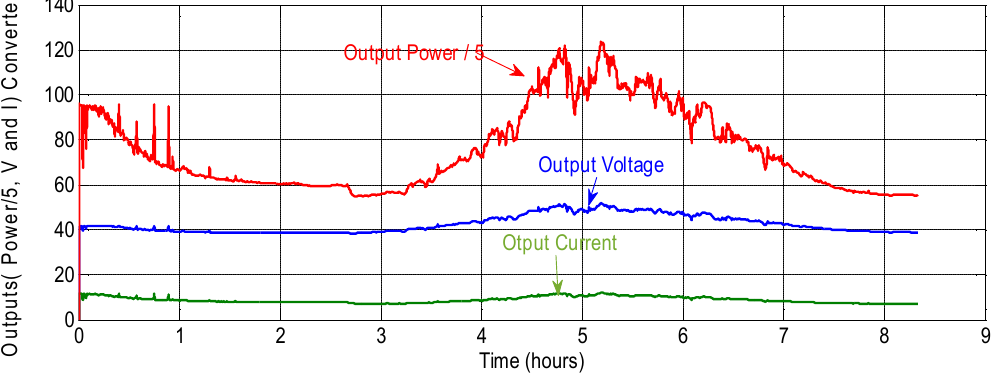
Figure 18. Outputs (current, V0, and power) vs. time.